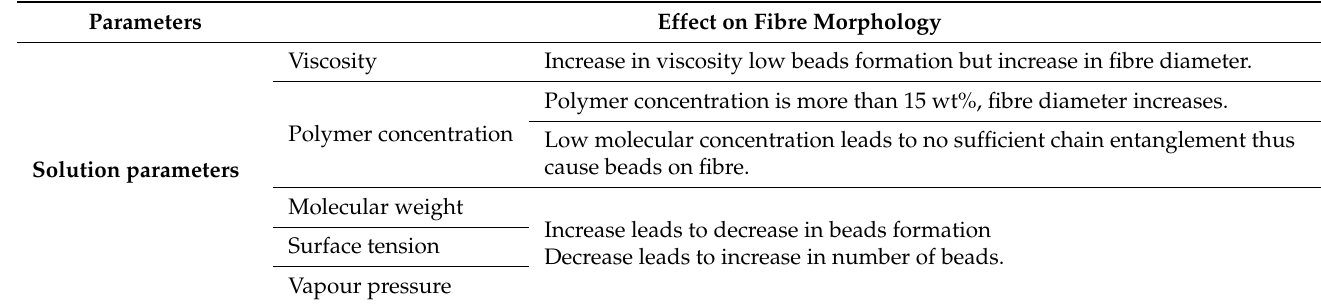
Table 8. Factors affecting the solution-blowing process